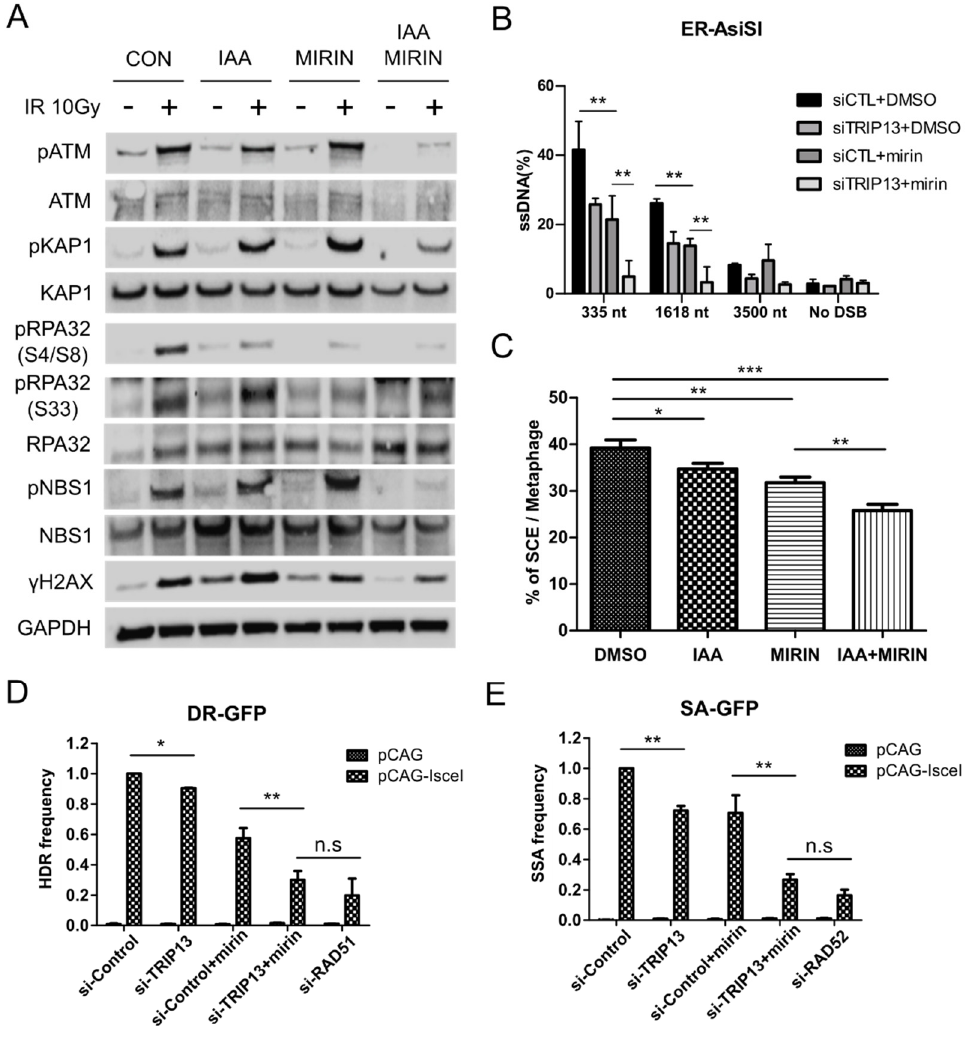
Figure 4. TRIP13 enhances HR by regulating ATM downstream signaling and DNA end resection independent of MRE11 exonuclease activity. ( A ) IR-induced (one-hour irradiation) ATM downstream signaling pathways were downregulated upon TRIP13 degradation with mirin treatment. ( B ) A quantitative DNA resection assay using the ER − AsiS I system showed that TRIP13 knockdown and mirin treatment inhibited DNA end resection. ( C ) SCE formation was reduced upon mirin treatment with TRIP13 depletion. ( D , E ) GFP-reporter assays showed the additive effects of TRIP13 knockdown and mirin treatment on HDR and SSA. The two-tailed unpaired T test was used to determine significance (* p < 0.05; ** p < 0.01; *** p < 0.001; n.s, not significant). TRIP13 depletion reduced the phosphorylation of RPA32(S4/8). Therefore, we per-